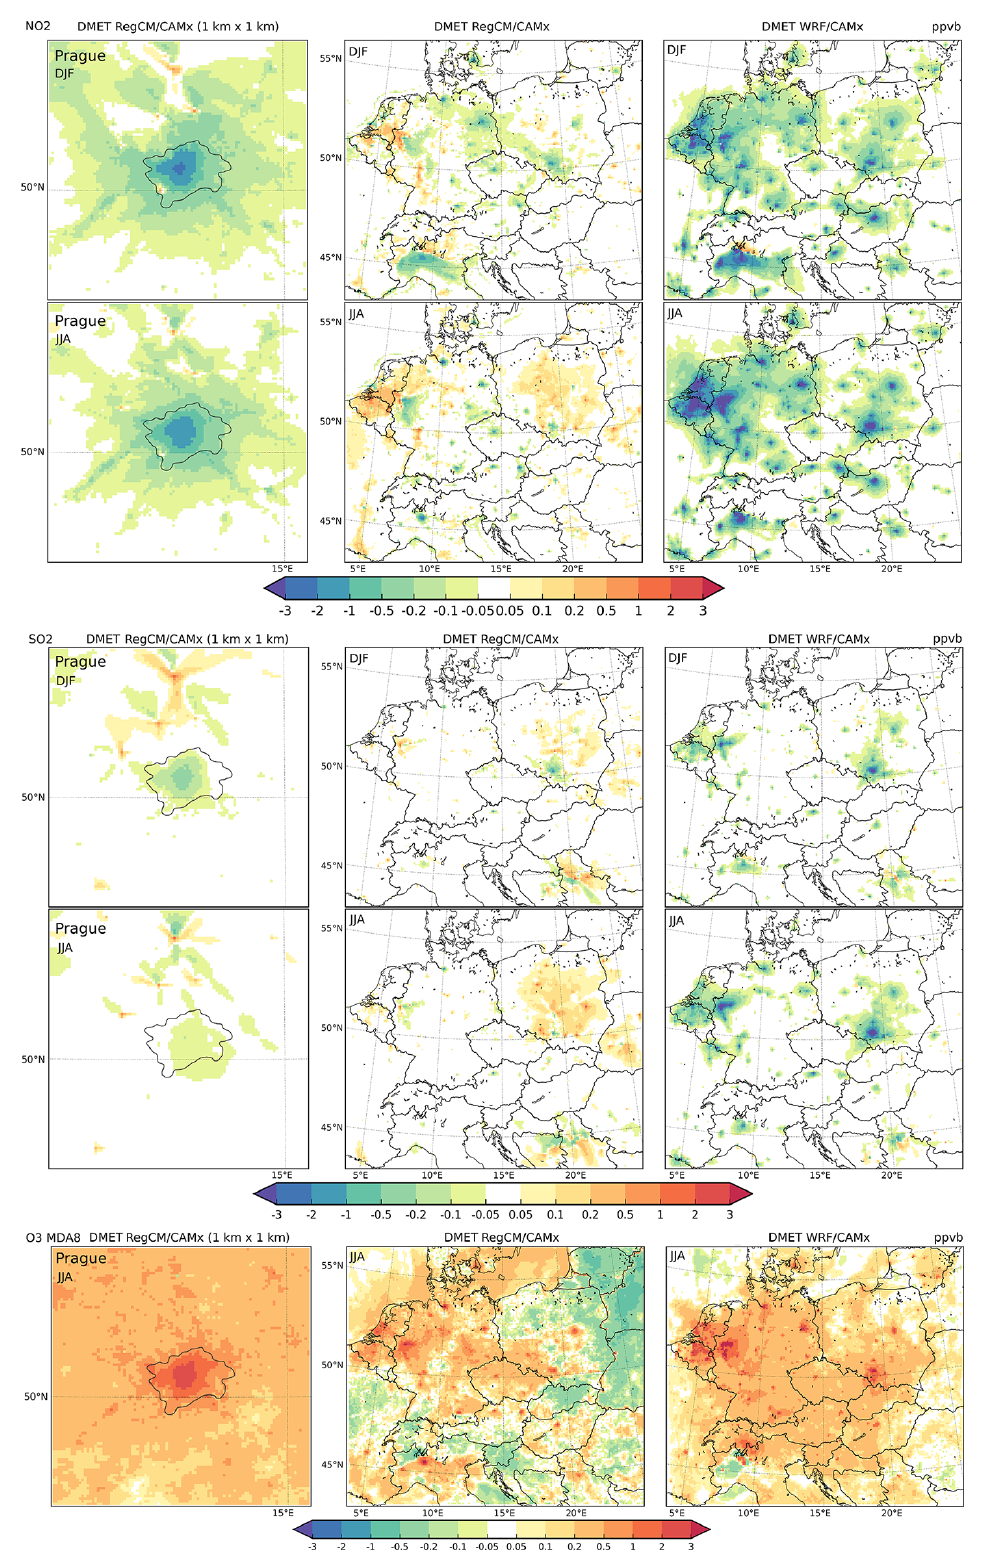
Figure 5. The spatial distribution of the 2015–2016 average impact of the urban canopy meteorological forcing (UCMF) DMET on NO 2 DJF and JJA (first and second row), SO 2 DJF and JJA (third and fourth row), and JJA MDA8 O 3 (fifth row). Columns represent the results from the 1km RegCM/CAMx (detail of Prague), 9km RegCM/CAMx, and 9km WRF/CAMx simulations. Units are in parts per billion by volume